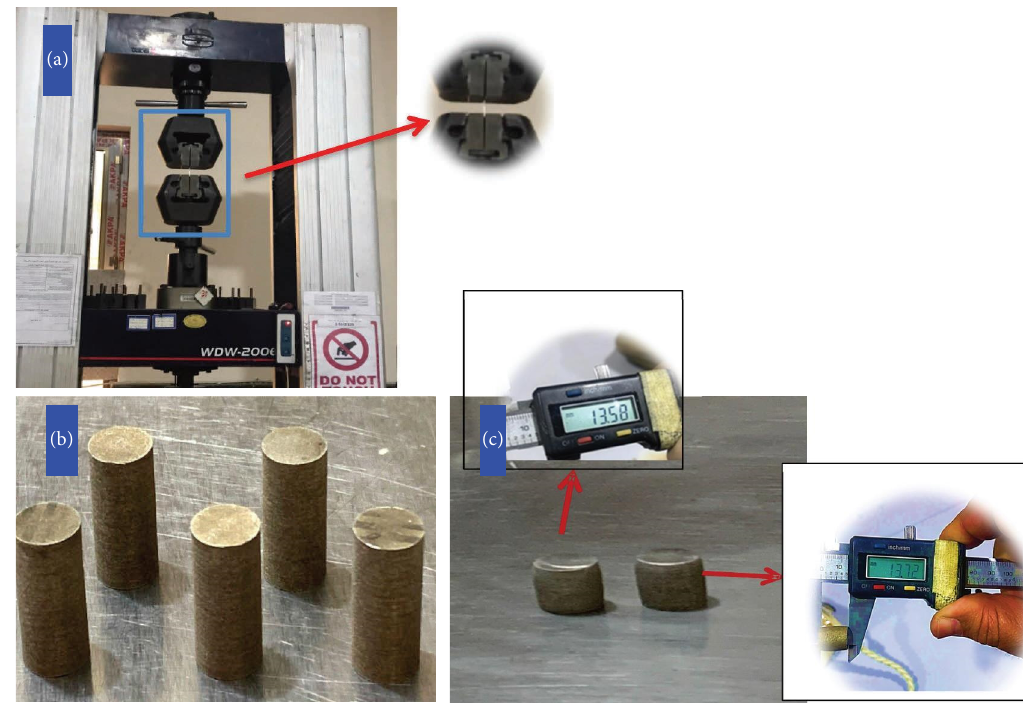
Figure 12: (a) Compression testing. (b) Samples before testing. (c) Samples after testing.